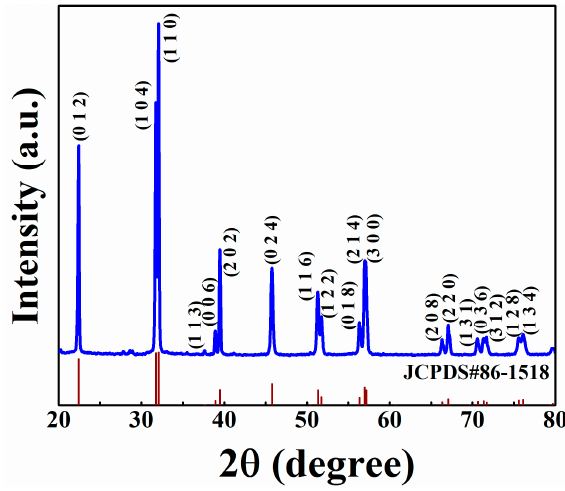
Figure 1. XRD pattern of BiFeO 3 (BFO) powders.